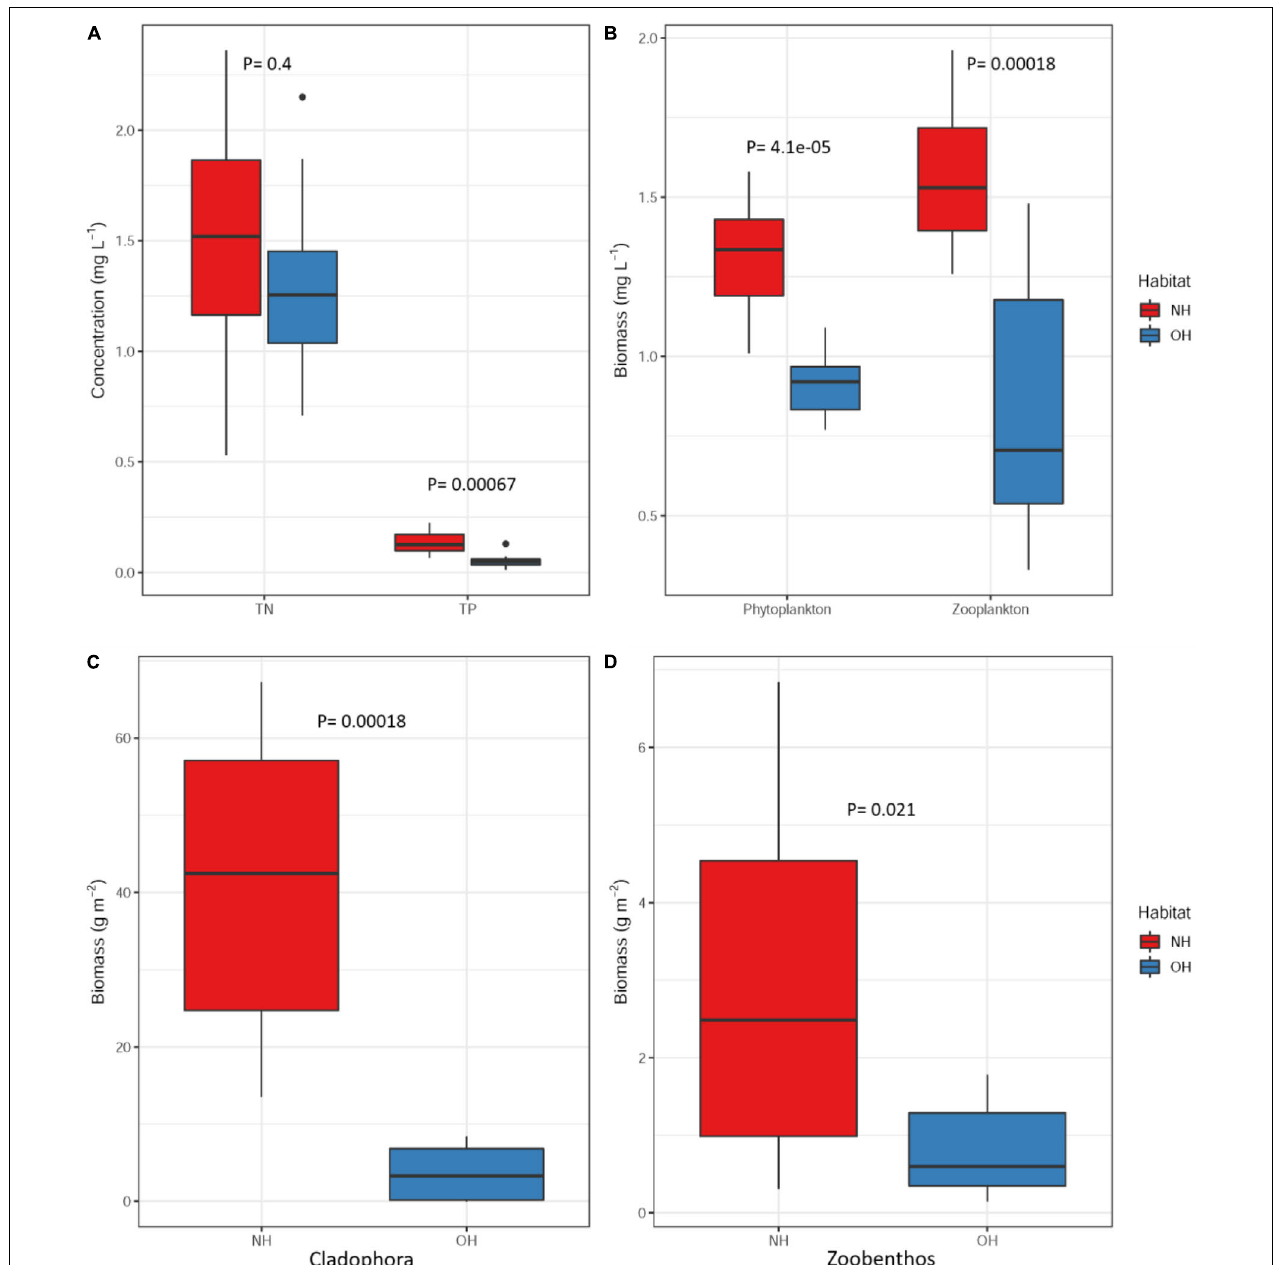
FIGURE 1 | Changes in total phosphorus and total nitrogen (A) , phytoplankton and zooplankton biomass (B) , Cladophora biomass (C) , and zoobenthos biomass (D) in Qinghai Lake between original (blue) and new (red) habitats. P -values are marked above the box